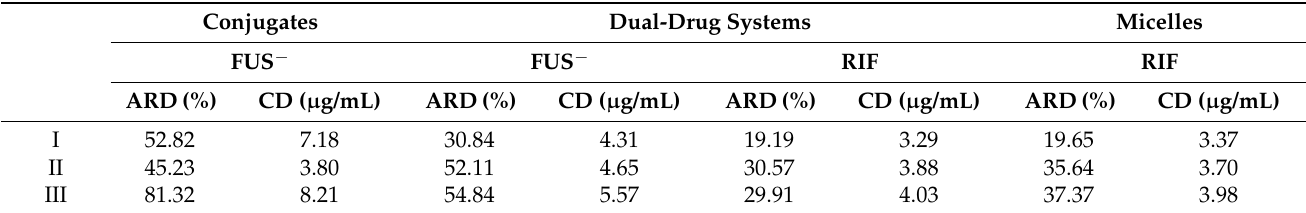
Figure 5. Kinetic release profiles of RIF from various types of carriers: ( a ) micelles and ( b ) dual-drug systems or FUS from ( c ) conjugates and ( d ) dual-drug systems, based on PIL graft copolymers I–III. Table 3. Data for drugs released from carriers I–II based on TMAMA. Conjugates Dual-Drug